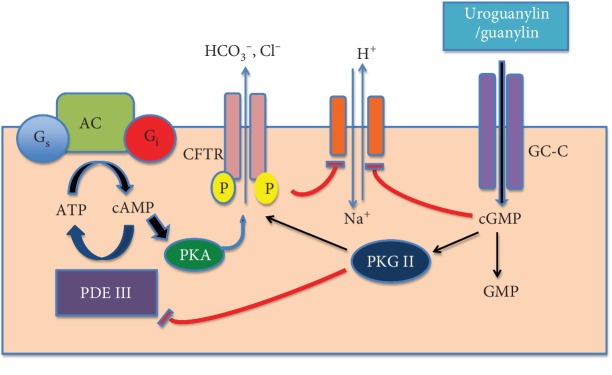
Activation cascade of binding of uroguanylin to guanylate cyclase-C receptor on the intestinal epithelial cell. Binding of uroguanylin to guanylate cyclase-C results in receptor activation, catalyzing the production of cyclic guanosine monophosphate (cGMP). Cyclic GMP can activate cGMP-dependent protein kinase II (PKGII) or inhibit the activity of a cyclic adenosine monophosphate- (cAMP-) specific phosphodiesterase, PDE III, thereby crossactivating cAMP-dependent protein kinase (PKA). PKGII and PKA phosphorylate the cystic fibrosis transmembrane conductance regulator or CFTR, increasing its chloride-secreting activity and preventing the absorption of sodium [37].